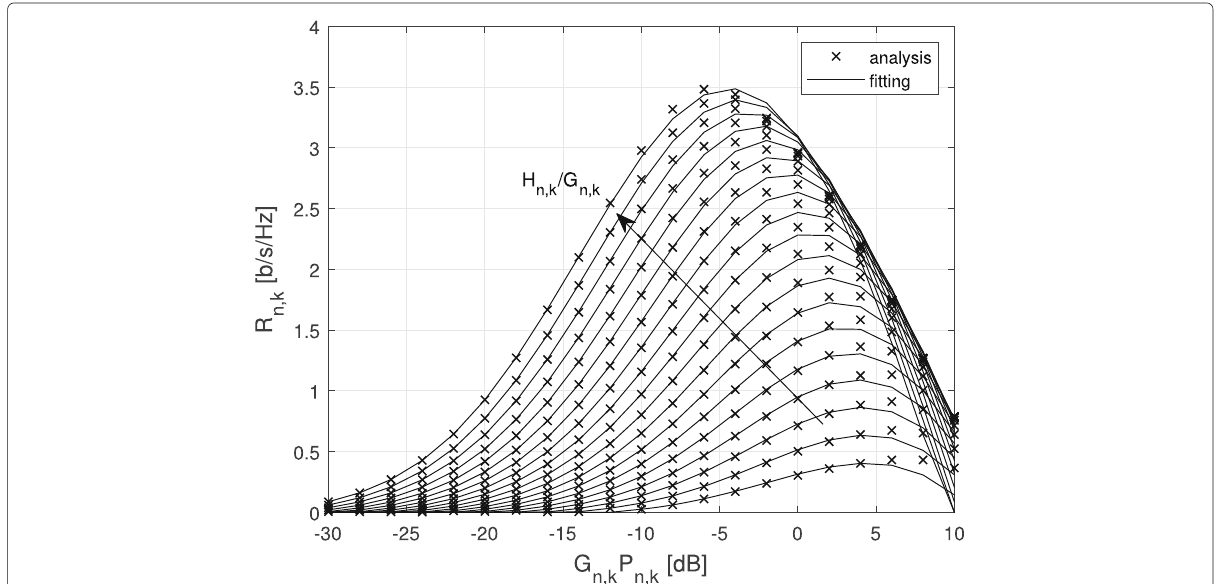
Fig. 5 R n , k ( P n , k ) as a function of G n , k P n , k for values of H n , k / G n , k between 2 and 20 dB with a step of 1 dB, and results obtained with the fitting function (25), considering a 16-QAM constellation and m =